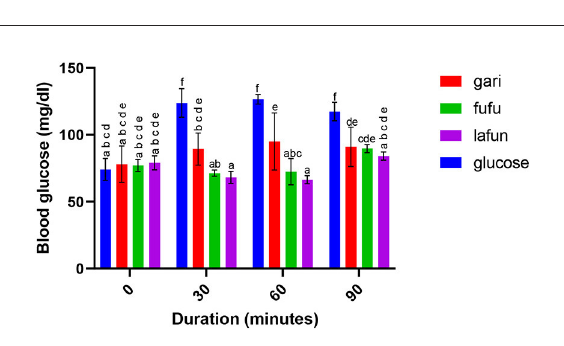
FIGURE5 Blood glucose response after the intake of fufu, lafun and gari from IITA-TMS-IBA182986. Mean values with different letters are significantly different at p <